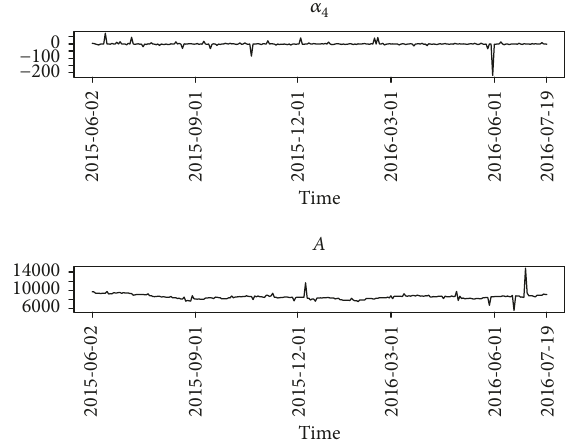
Figure 13: Time plots of model D coefficients- 𝛼 4 and 𝐴 .